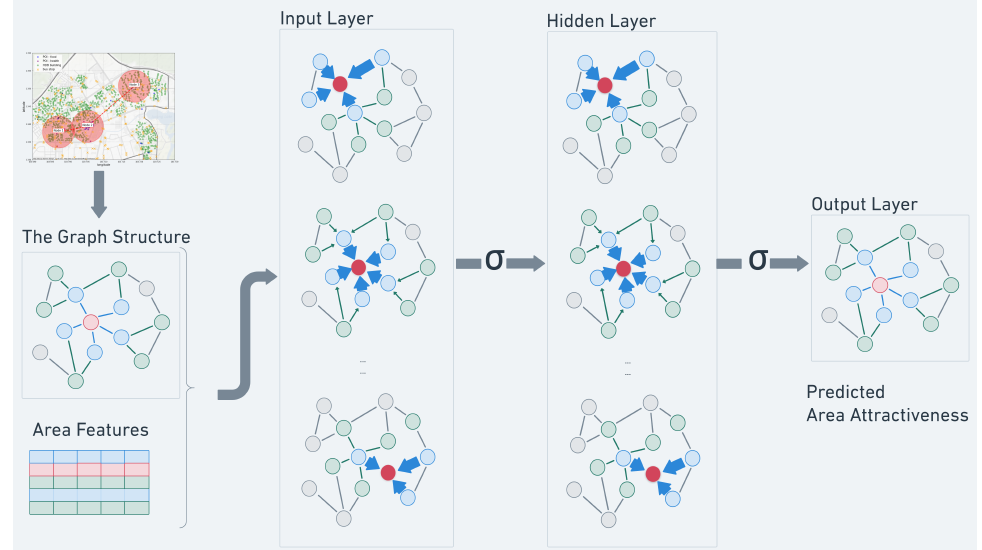
Figure 4. Visualization of the GCN model. The graph structure is built with the transportation network and shared throughout the model over layers. The input is multichannel node features and the output is single dimension node